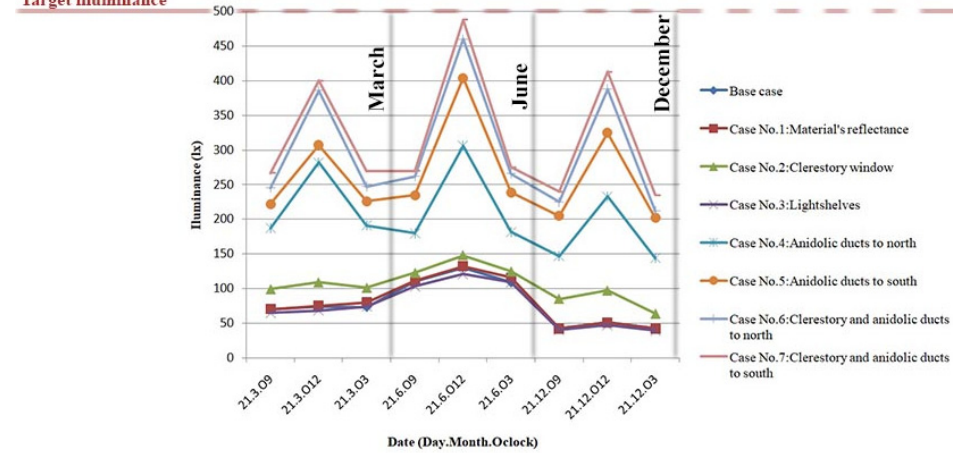
Figure 26. Comparison of illuminance levels of the suggested cases on the board.